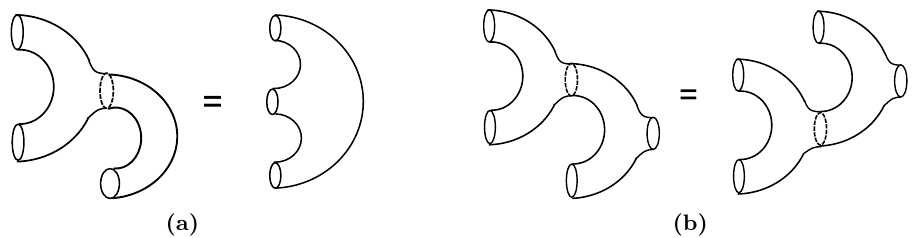
! R corresponds to gluing N;M ! V N;M means the equivalence of N;M